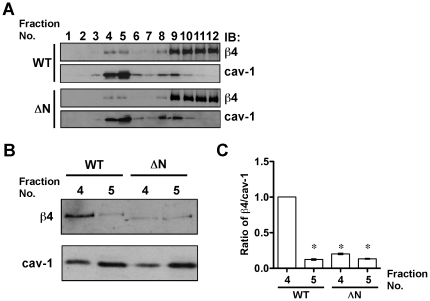
Effects of ΔNß4 integrin on lipid raft localization.(A) After lysis in 1% Brij98, WT or ΔNß4-expressing keratinocytes were fractionated by sucrose gradient ultracentrifugation. The fractions from each WT and ΔN keratinocytes were independently blotted to the membrane and probed with antibody against ß4 integrin (ß4), and then reprobed with antibody against caveolin-1 (cav-1). (B) Fractions 4 and 5, which were lipid raft fractions, were blotted onto the same membrane and probed with antibody to ß4 integrin (ß4), and then reprobed with antibody to caveolin-1 (cav-1). (C) Results of the densitometric analysis are shown as the integrated density of the ratio of ß4 integrin to caveolin-1 bands in Figure 3B, which was 1.0 for fraction 4 from WT keratinocytes. *P<0.001 (one-way ANOVA, Bonferroni post test) vs. WT. All blots are representative for at least three independent experiments.